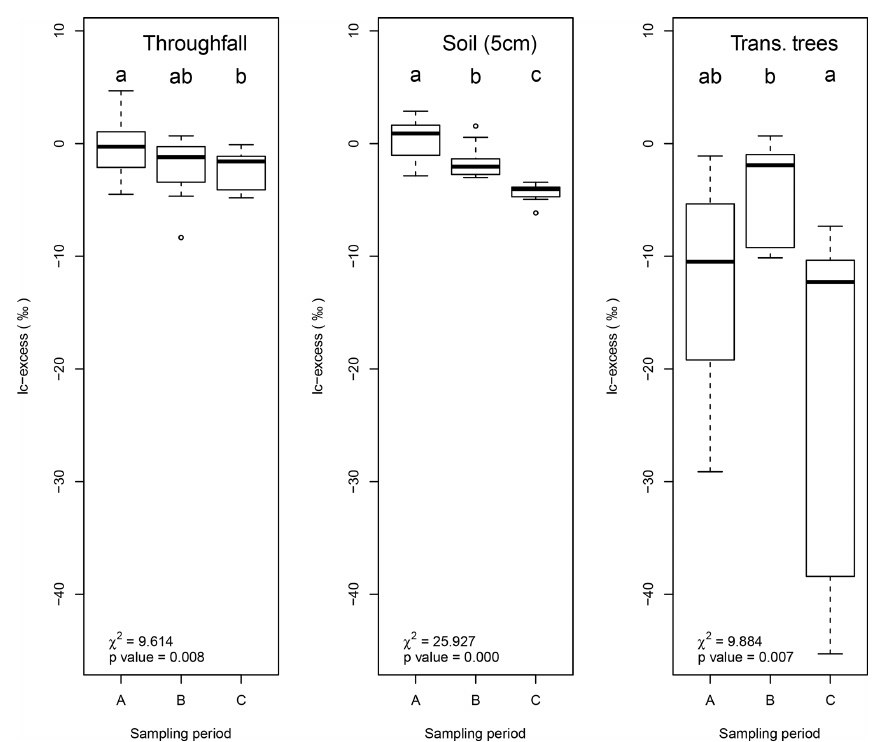
Figure 8. Box plots showing the temporal differences in lc-excess for throughfall, soil water at 5cm depth and tree transpiration. The other sample types did not show significant differences ( p = 0 . 05). Sampling periods with the same lowercase character per sample type do not differ ( p = 0 .